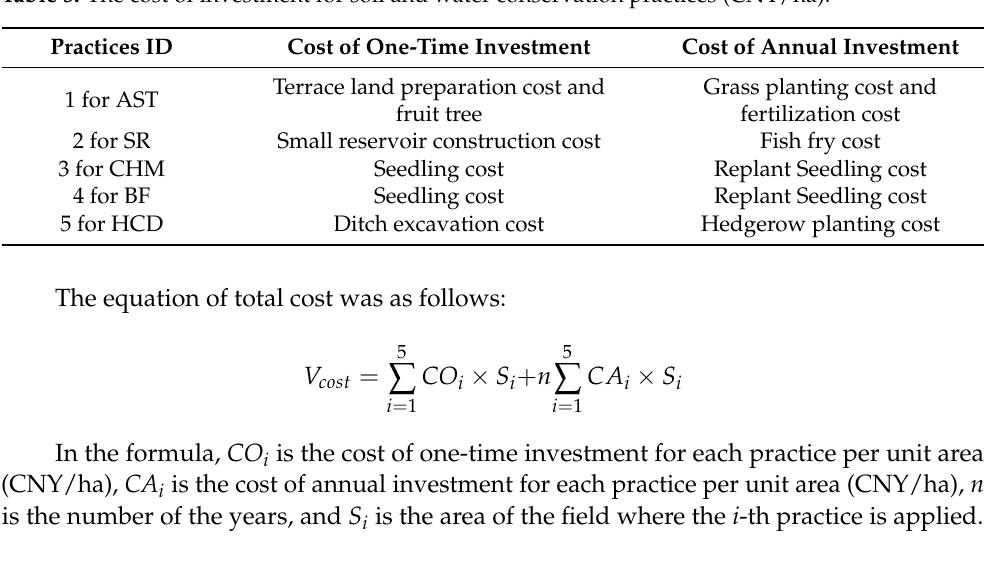
Table 5. The cost of investment for soil and water conservation practices